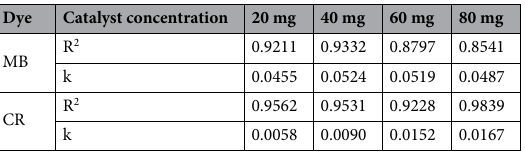
Table 2. Variation in best fit degradation kinetic parameters for MB and CR with the CSC dose.